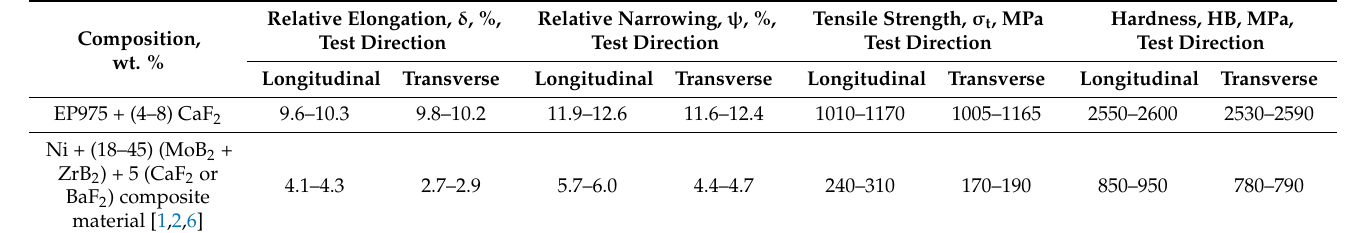
Table 7. Comparative Mechanical Properties in Longitudinal and Transverse Directions for the Studied and Known